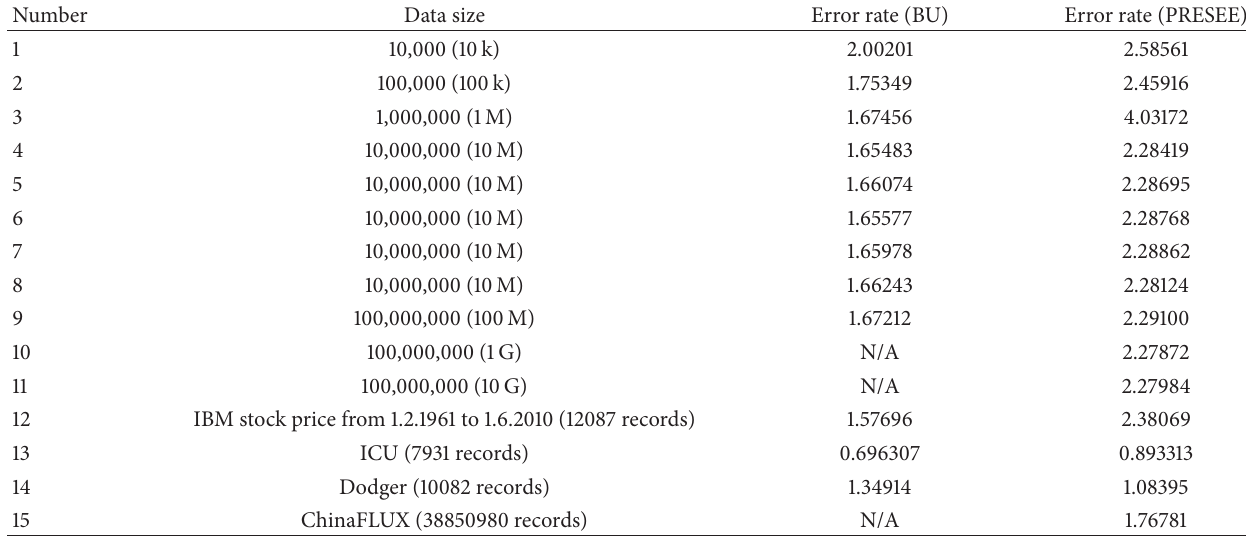
Table 2: Precision of